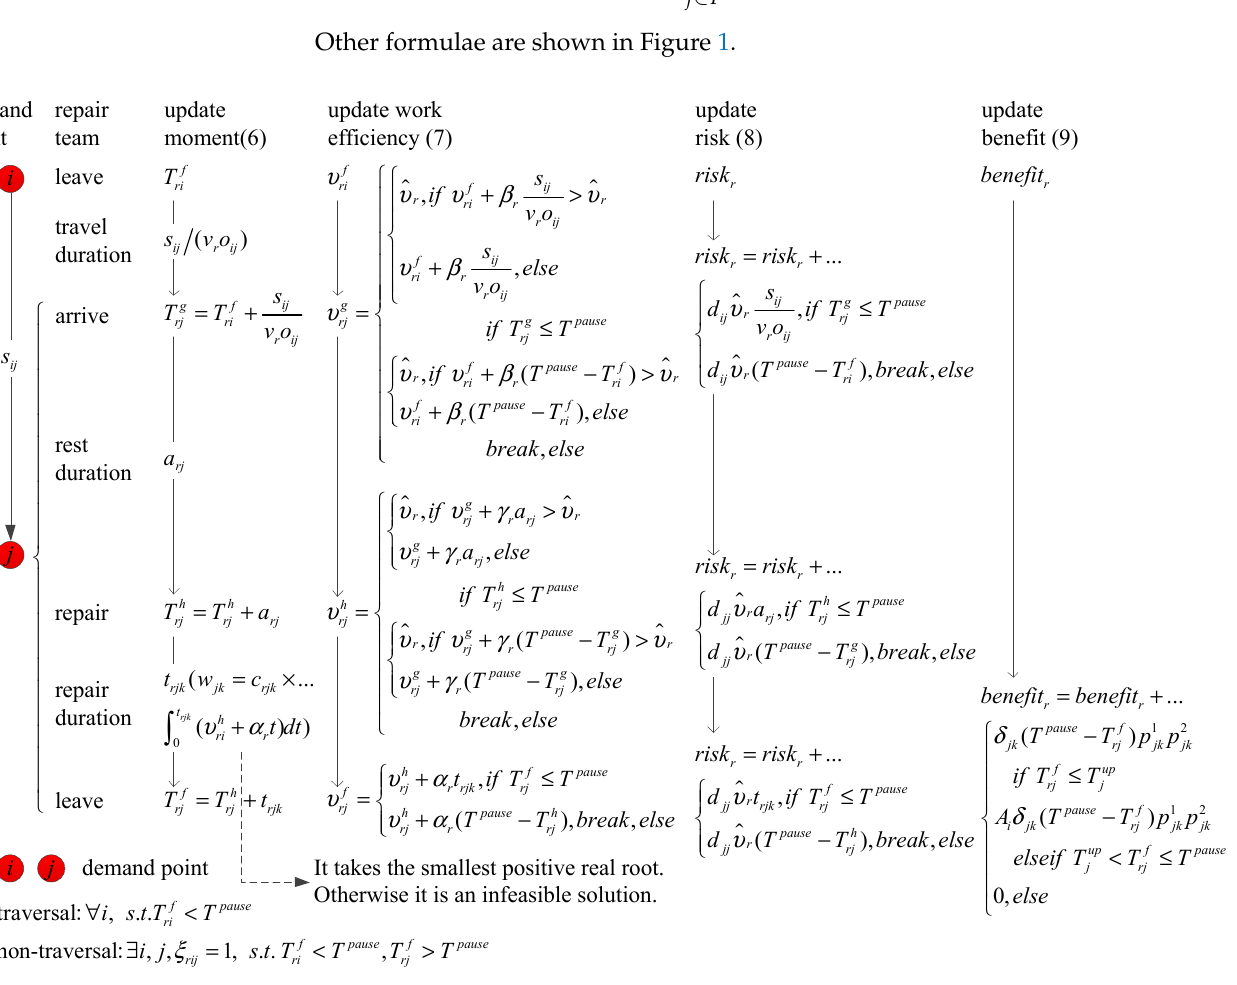
Figure 1. Work flow of a repair team